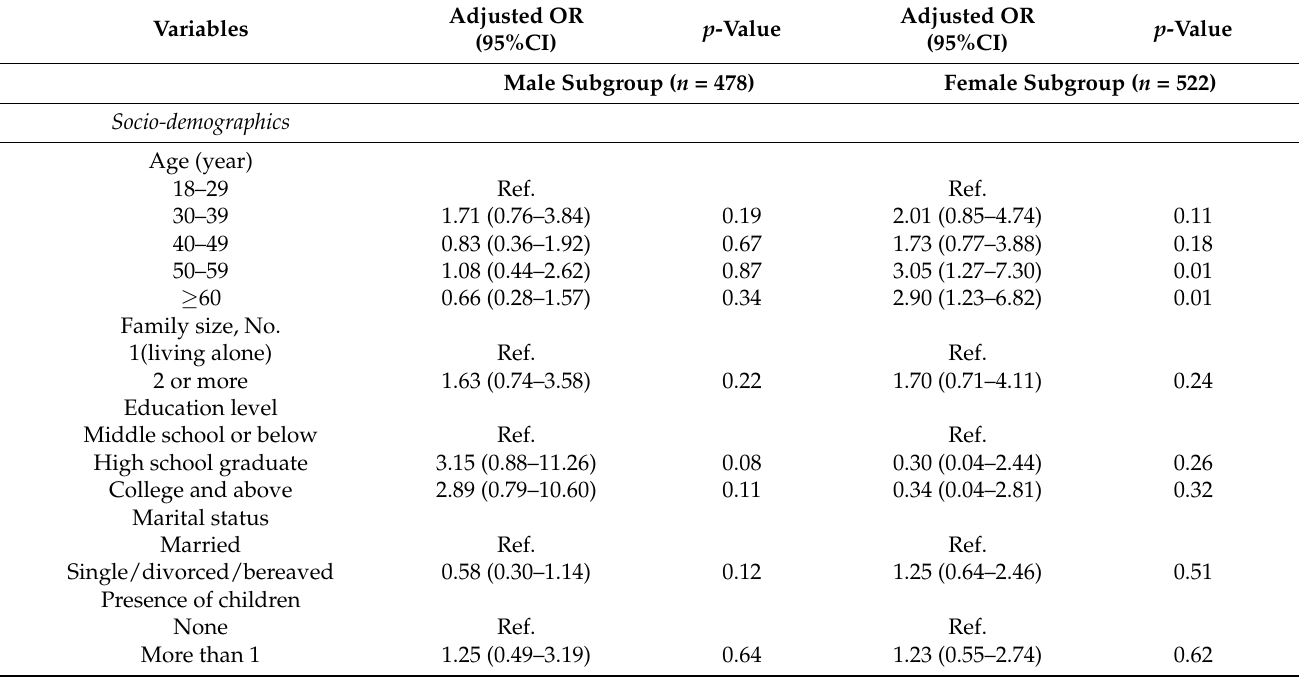
Table 4. Influencing factors associated with healthcare utilization avoidance among subgroup participants along with